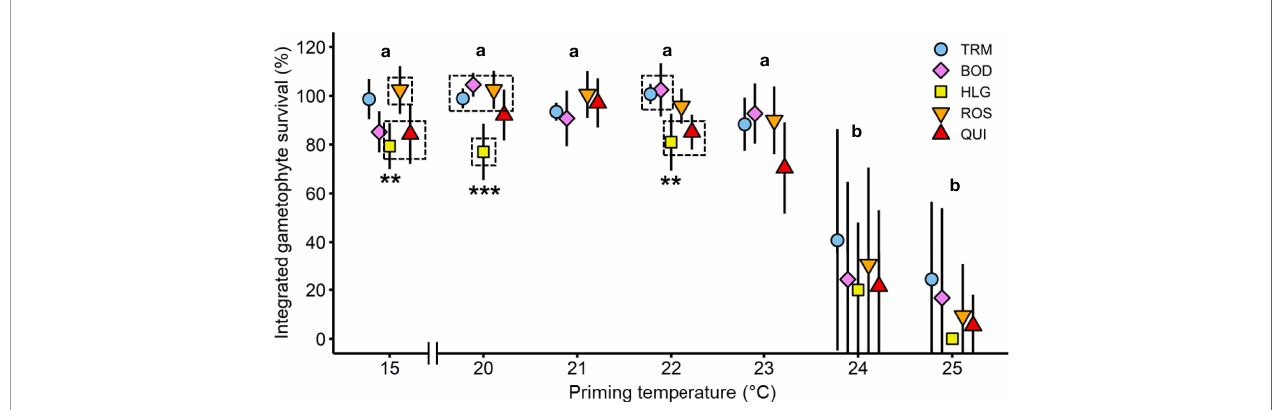
FIGURE 3 | Integrated gametophyte survival over time of Laminaria digitata along a temperature gradient in experiment 1. Mean relative gametophyte survival between day 4 and 28 for priming treatments 15-25°C for Tromsø (TRM; n = 5; day 28, n = 4), Bodø (BOD; n = 5), Helgoland (HLG; n = 4), Roscoff (ROS; n = 5; day 21-28, n = 3) and Quiberon (QUI; n = 5; day 21-28, n = 4) averaged over six (BOD: fi ve; HLG: three) points in time. Letters indicate statistical differences in survival between treatments within each population (ANOVA; Tukey test, p < 0.01). Asterisks and dashed boxes denote the degree of signi fi cant differences between populations within treatments (ANOVA, Tukey test, p < 0.05). Values are expressed as the mean of means ±